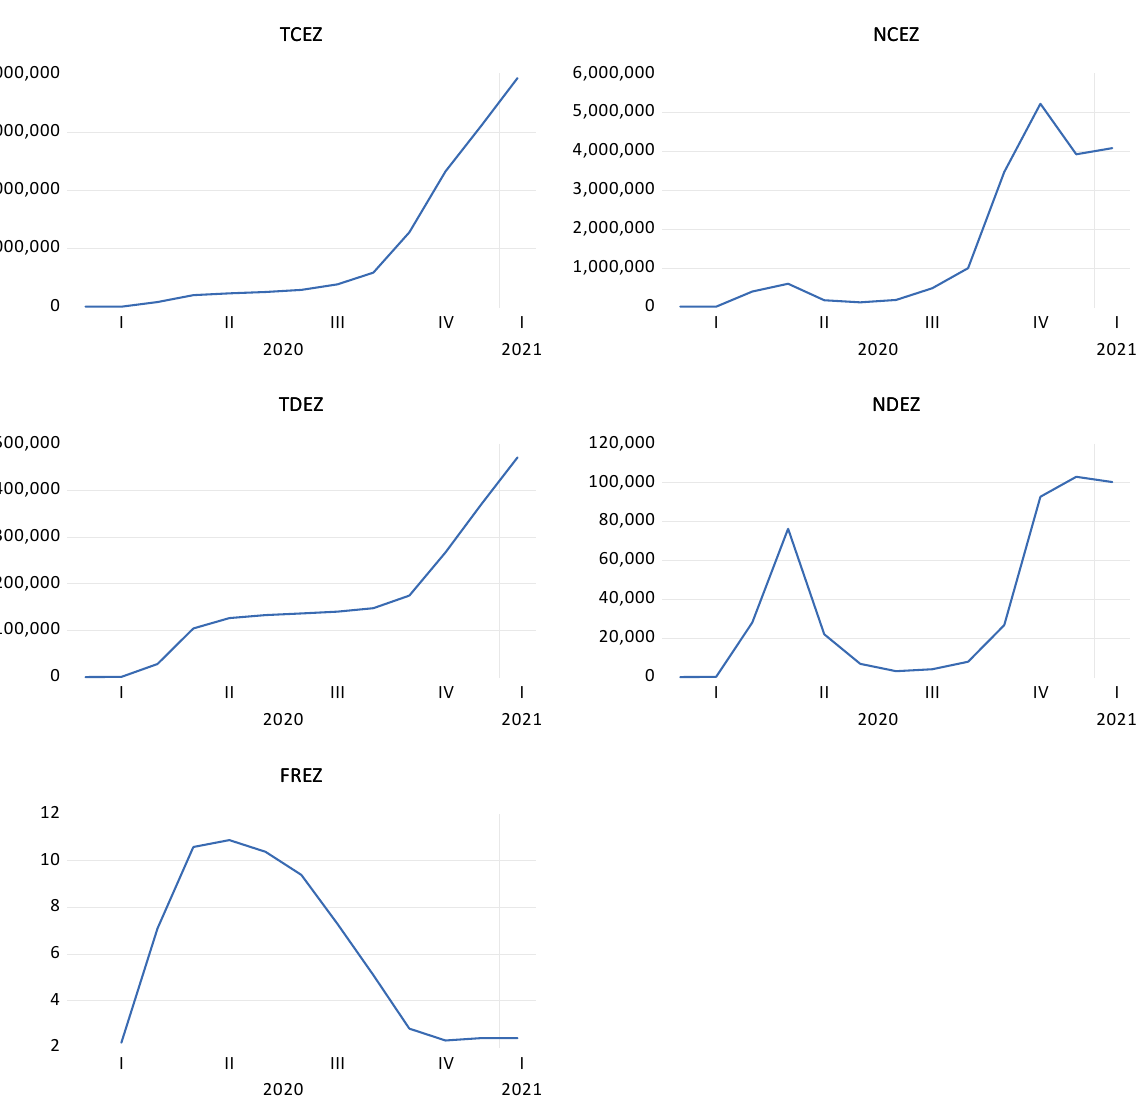
Figure A1. Source: compiled by the authors based on World Health Organization Coronavirus Disease 2019 (COVID-19) situation reports and the Our World in Data Coronavirus Pandemic (COVID-19) (Roser et al. 2020) database. Note: I = 1st quarter, II—2nd quarter, III—3rd quarter, IV—4th quarter. For TCEZt, NCEZt, TDEZt, NDEZt, and FREZt, see Table 1.